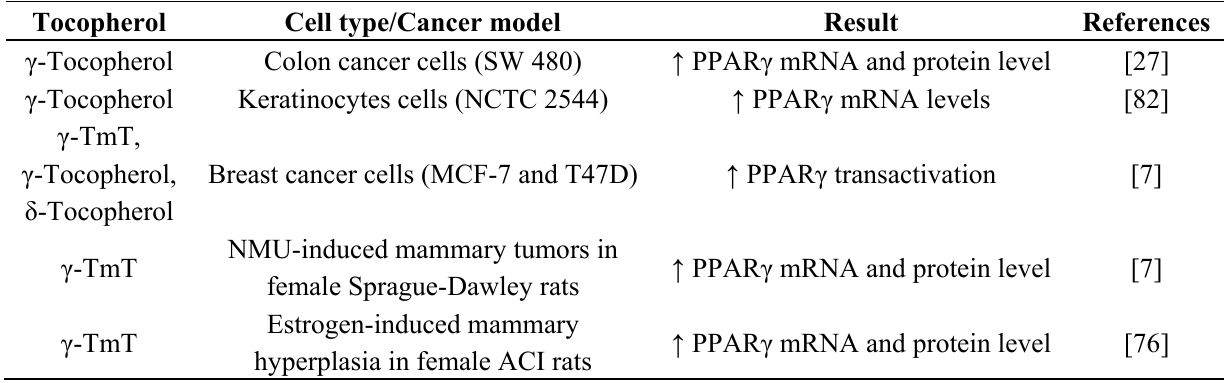
Table 1. Tocopherols induce PPAR γ